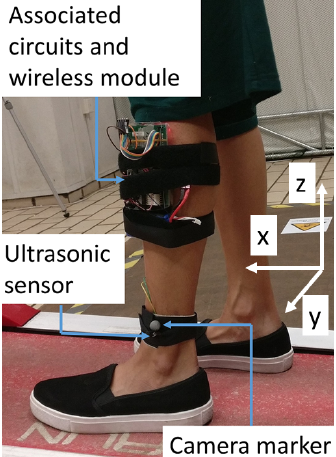
Figure 5. The mobile node and camera marker attached to left lower